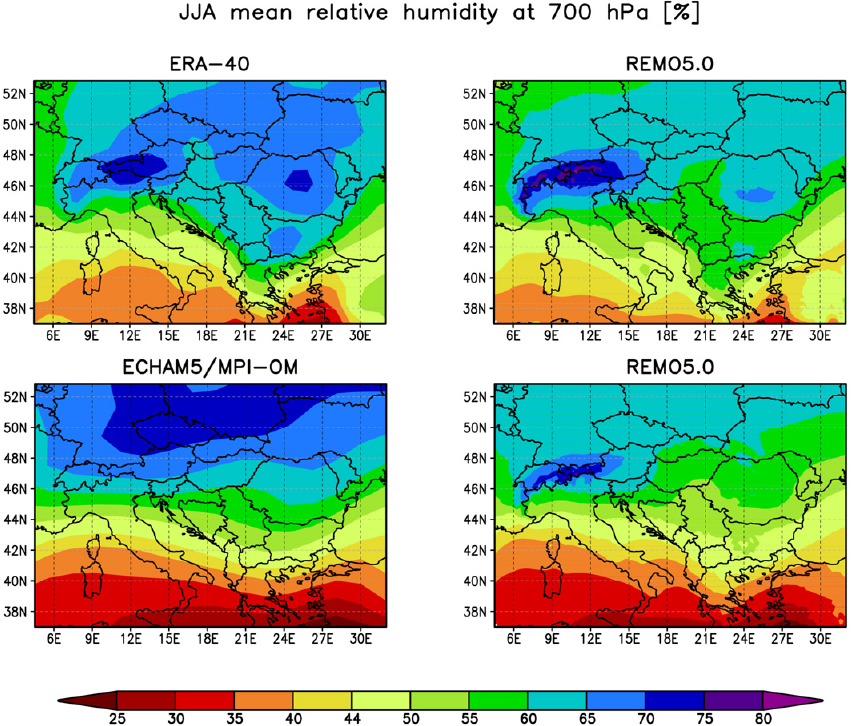
Figure 6. Summer mean relative humidity [%] at the level of 700hPa in the REMO simulations (top right: ERA40-driven REMO, bottom right: ECHAM-driven REMO) and the corresponding global fields (top left: ERA40, bottom left: ECHAM5 / MPI-OM) for